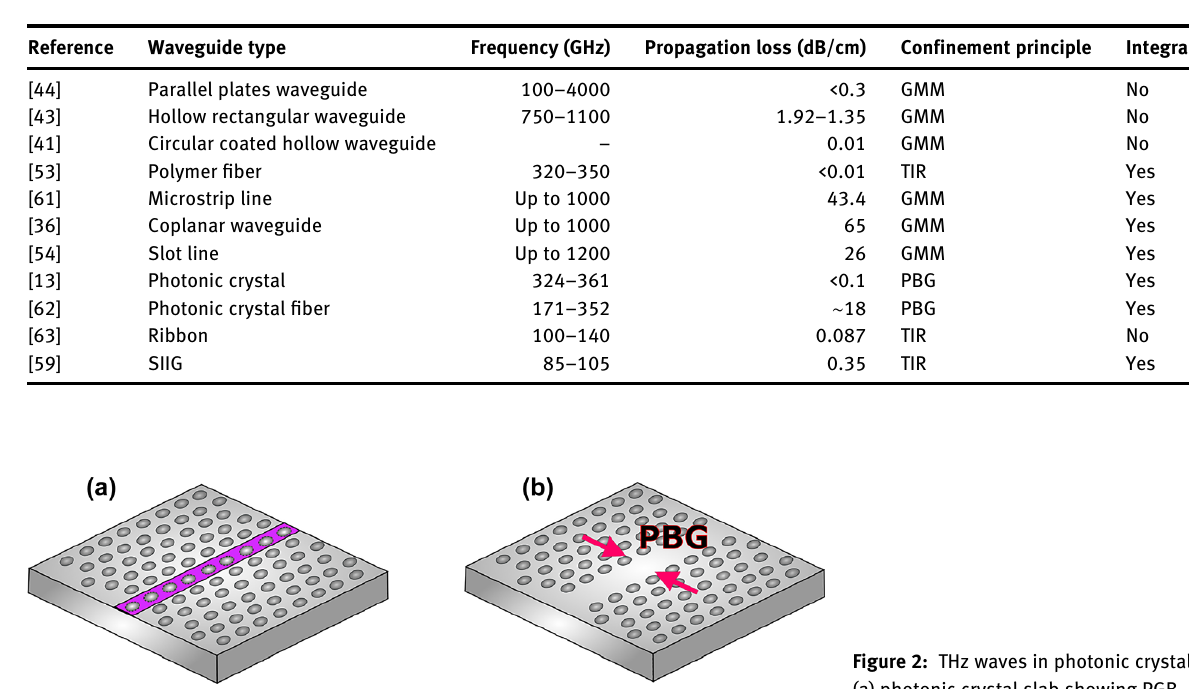
Figure 2: THz waves in photonic crystals, (a) photonic crystal slab showing PGB effect and removable holes (purple region) to create waveguide track, (b) photonic crystal waveguide showing PBG effect and (c) illustration of